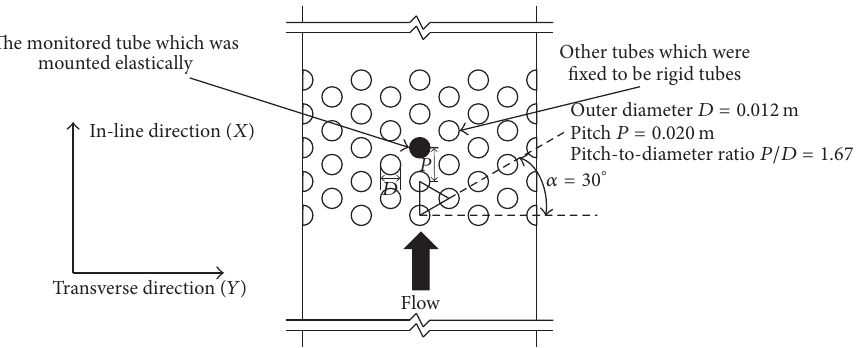
Figure 1: Schematic of the tube bundle installed in the test section of the experimental